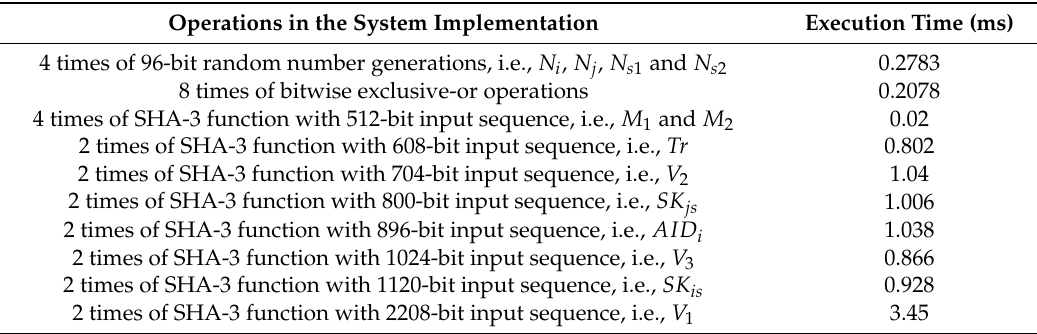
Table 5. The details of the implementation of the authentication phase with Tr seq .